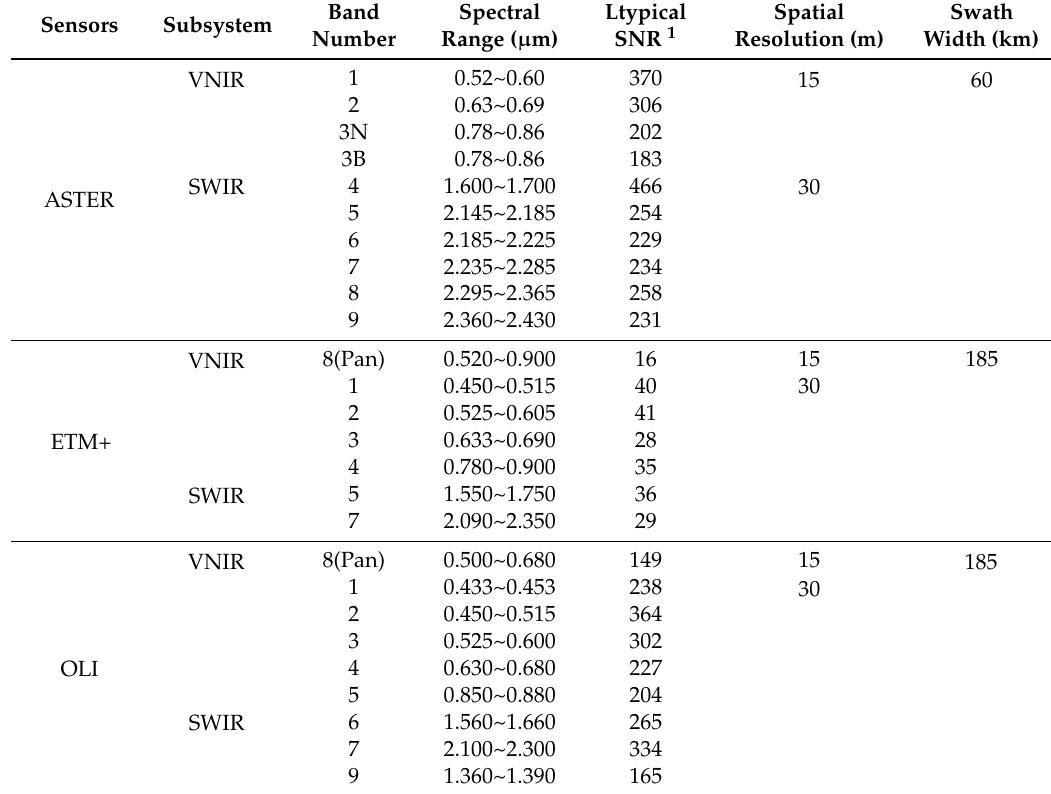
Table 1. Performance characteristics of the ASTER, ETM+, and L8 OLI